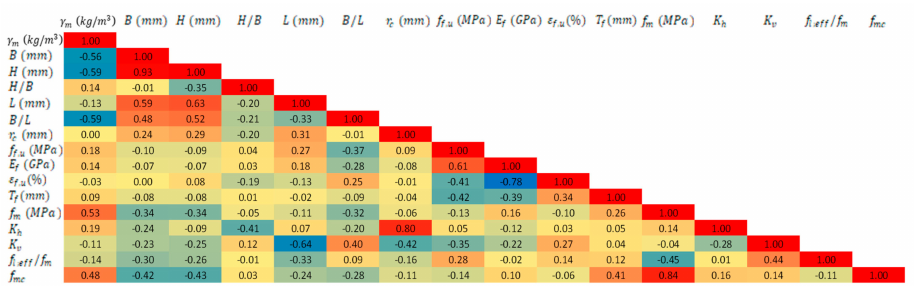
Figure 2. Correlation matrix of dataset features.